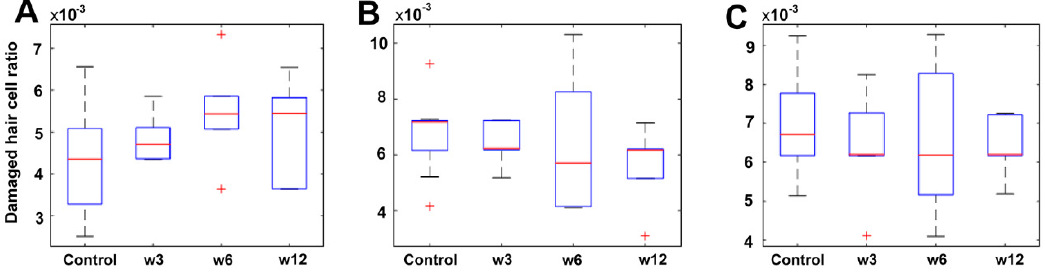
Figure 19. Overview of the damaged hair cell ratio from data collected at sea experiments. ( A ) Lagena, ( B ) saccule, ( C ) utricle. The red line is the median with the boxes defined by the 25th and 75th percentiles. The whiskers are defined by 1.5 times the interquartile distance and outliers (+) beyond that range. No significant differences were found between controls and exposed salmons ( p -values ( A ) 0.29, ( B ) 0.38, ( C ) 0.78).